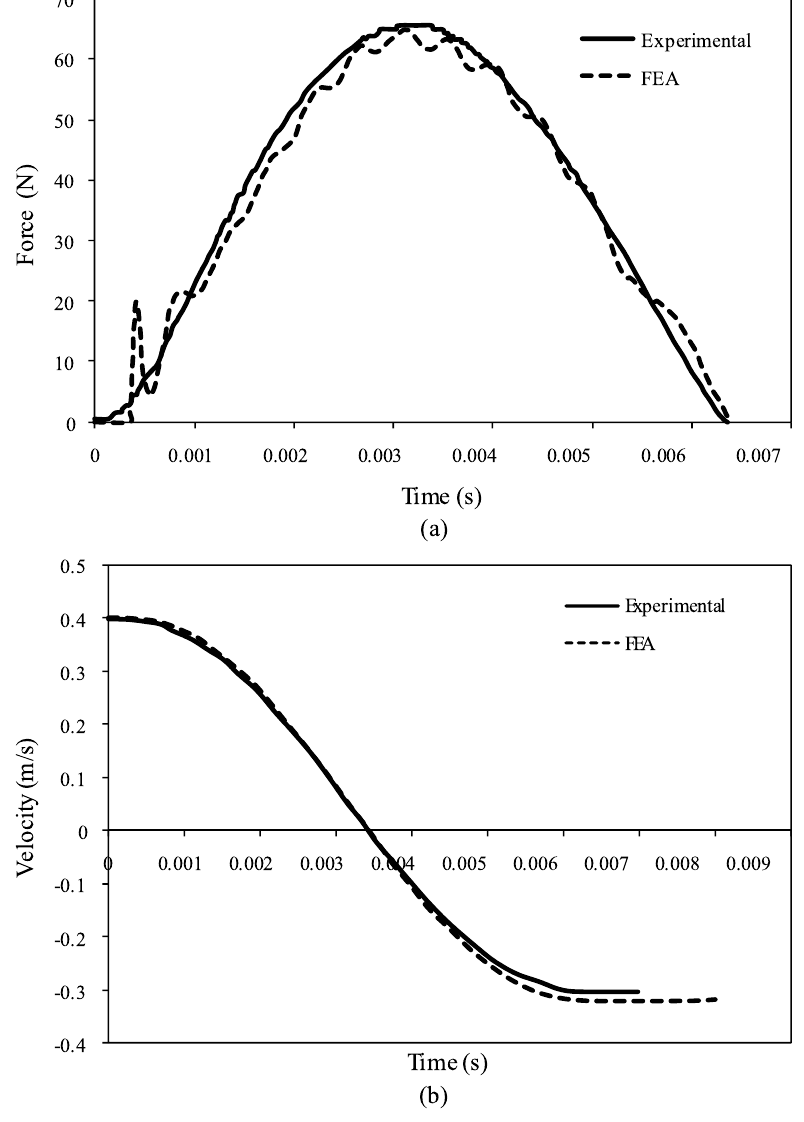
Fig. 9. Comparison of experimental and computed force (a) and velocity (b) as functions of